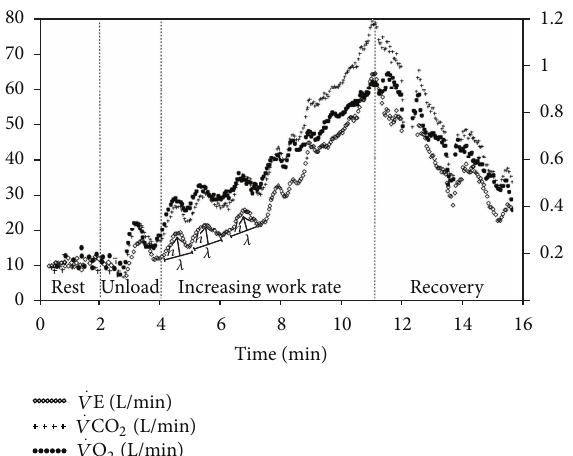
Figure 10: Exertional oscillatory ventilation (EOV) during incremental CPET in a 56-yr-old male with severe CHF. EOV was defined by regular (standard deviation of three consecutive cycle lenghts (𝜆) within 20% of their average) and ample (minimal ℎ of 5L/min) cycles of ̇ 𝑉 ) oscillations [27]. A similar oscillatory pattern is also seen in oxygen uptake ( ̇ 𝑉 ventilatory ( E